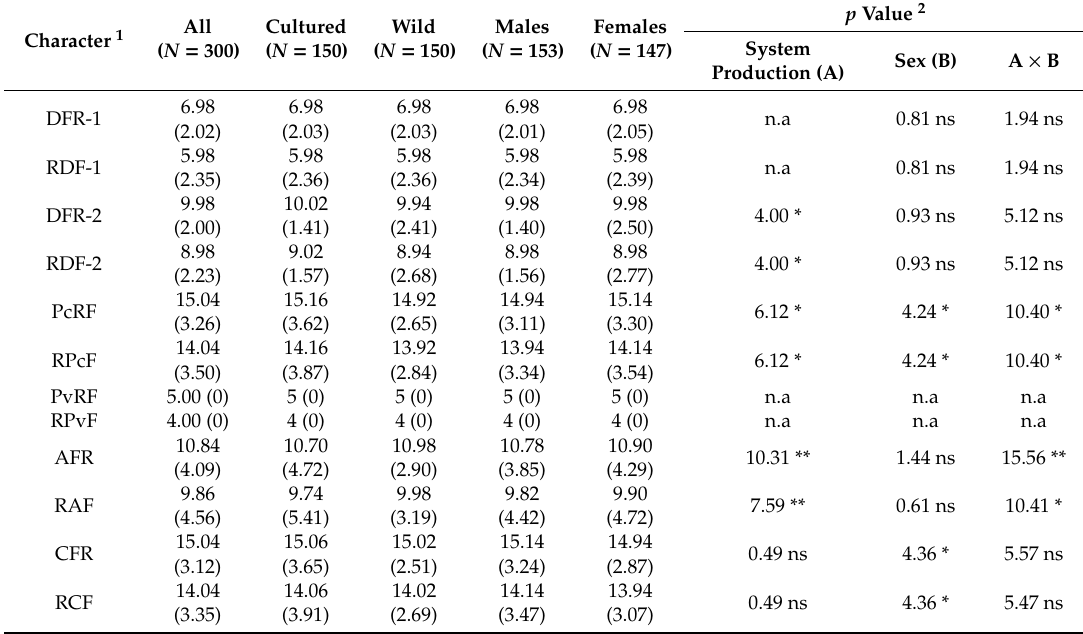
Table 3. Descriptive statistics of the meristic characters (original data) of Dormitator latifrons from hatchery and wild populations for each sex (mean